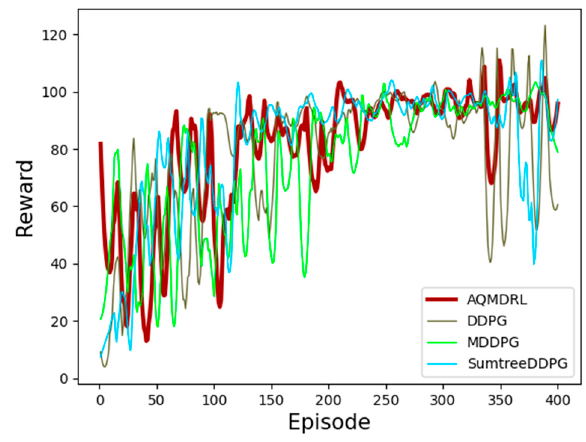
Figure 6. Ablation experiment